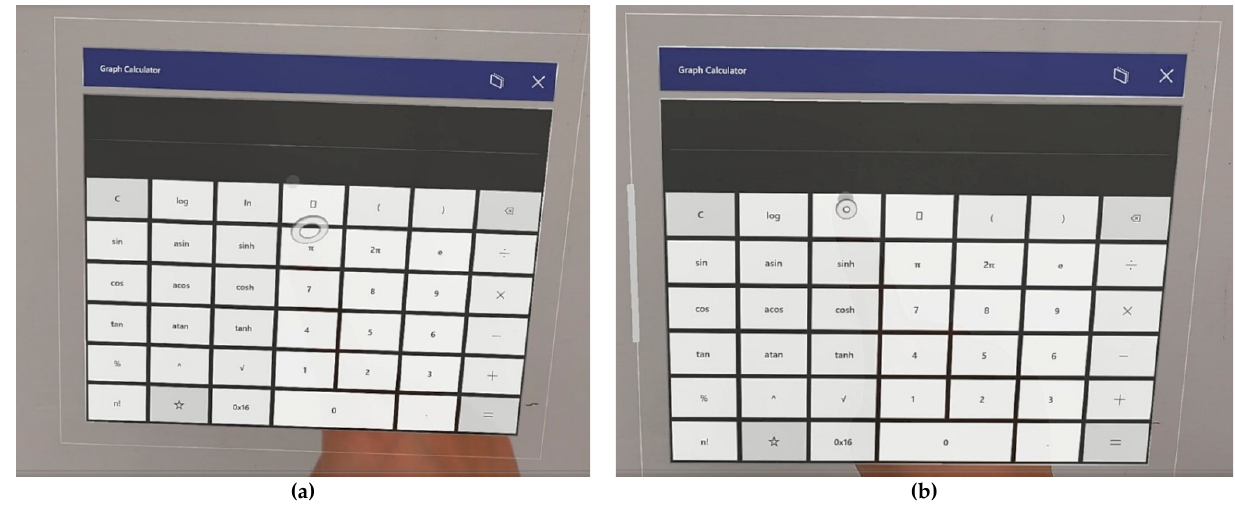
Figure 4. A virtual ring indicating the location of the fingertip in front of a virtual panel ( a ) approaching the key “ln”; ( b ) almost touching.